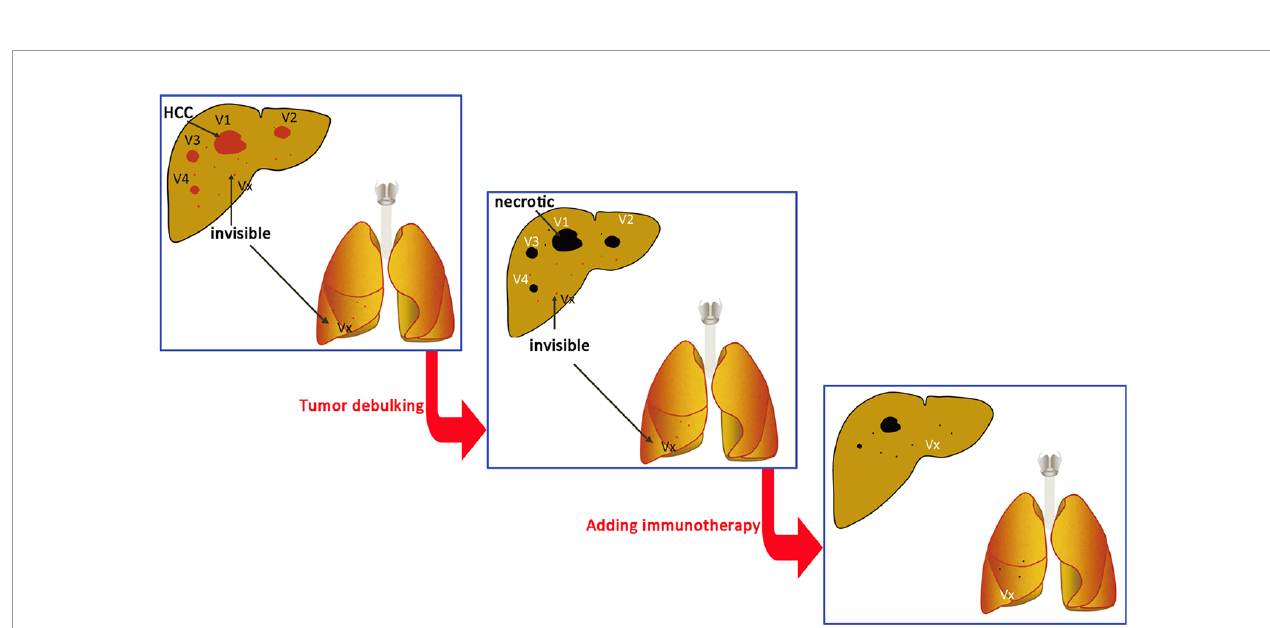
FIGURE 9 | Immune cell treatment performed at the same time or after tumor debulking. V1, V2, V3 … Vn are radiographically visible intrahepatic tumors. Vx is a lesion that has not been detected by intrahepatic or extrahepatic imaging examination. The total tumor burden (volume total, VT) = V1 + V2 + V3 … + Vn + Vx. The goal of treatment is to reduce the tumor burden to VT = Vx and then use immune cells to treat